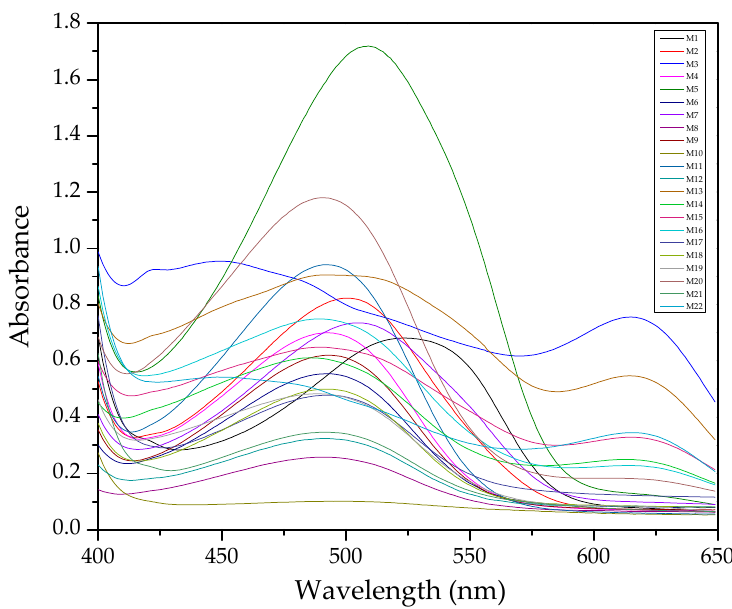
Figure 1. Visible spectra of the membranes after complexation for the system Dz-Hg(II).